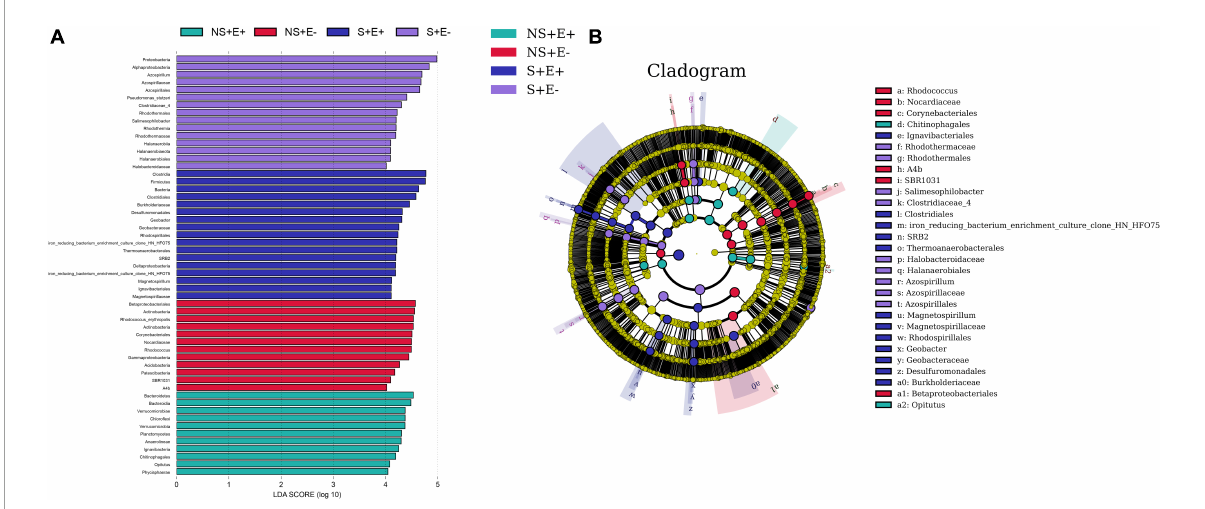
FIGURE8 The taxonomic differences between treatments based on E. ludwigii B30 inoculation and salt stress in bermudagrass. The LEfSe map of bacteria including LDA (A) and Cladogram (B) in rhizosphere soil. LEfSe map is a linear discriminant analysis based on the composition of sample taxonomy according to different grouping conditions. In the four treatments, P < 0.05, LDA > 4 as the standard, communities with significant differences at each classification level are found to be represented by bar chart. Cladogram can intuitively show the difference information of samples at each classification level. “NS + ” represents bermudagrass grown without NaCl condition; “S + ” represents bermudagrass under 250 mM salt conditions. “E + ” represents the infection of Enterobacter ludwigii B30, “E–” represents the absence of E. ludwigii B30.